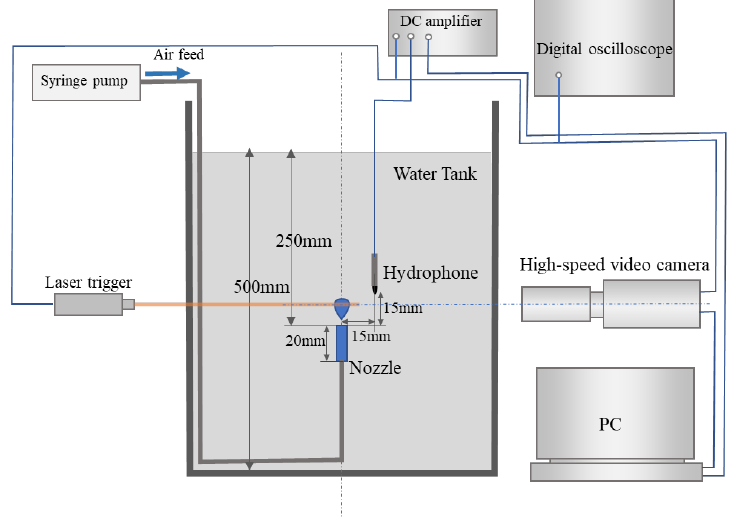
Figure 1. Experimental apparatus.